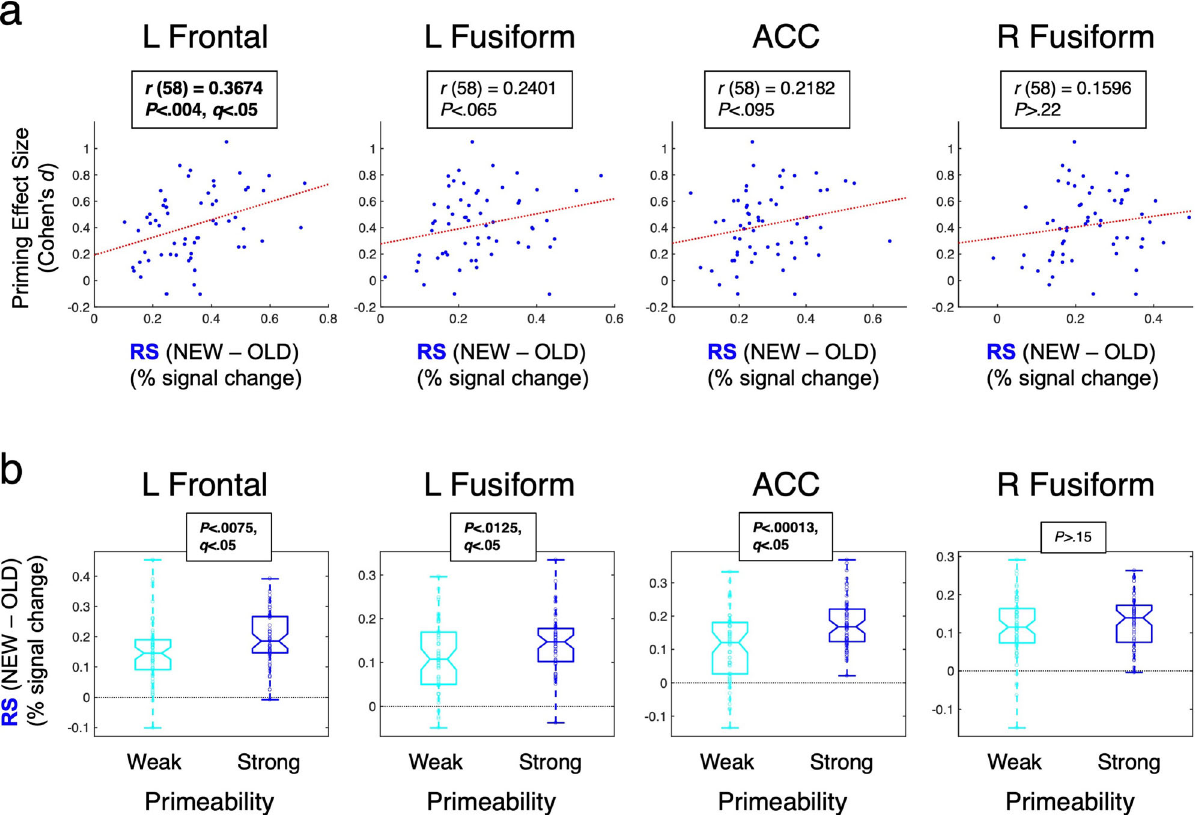
Fig. 5 Across- and within-participant relationships between repetition suppression and priming. a Correlations (Pearson) across participants between Repetition Supression (RS) magnitude (NEW – OLD) and priming effect size (Cohen ’ s d ) reveal a signi fi cant relationship in left frontal cortex and non- signi fi cant trends in left and right fusiform regions (left-most plot same as Fig. 3c). b Separating trials into Strong and Weak Primeable conditions show that signi fi cant within-participant relationships between RS and priming are found in left frontal, left fusiform, and ACC regions (greater RS in the Strong Primeable condition by paired t -tests). The middle horizontal line in each box plot represents the median (50th %ile), the horizontal lines just below and above the median represent the 25th and 75th %iles, the bottom and top horizontal lines represent the minimum and maximum values, and the boundaries of the horizontal notches inside the 25th and 75th %iles depict the 95% con fi dence limits of the median. Individual datapoints are plotted as open circles. Statistics (paired t -tests) are based on N = 60 independent participants (combining Overt and Covert Naming), and multiple comparisons were corrected by FDR ( q <